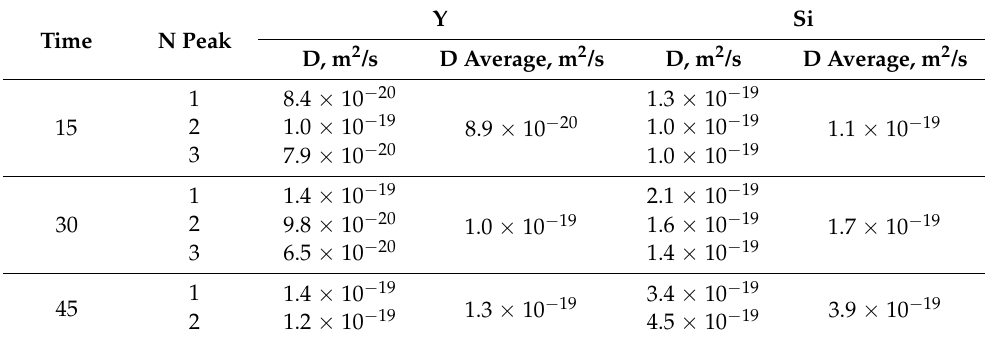
Table 2. The relationship between silicon and yttrium diffusion rates in the layers and its effect on annealing time at a temperature of 700 ◦ C in a multilayer [20]: coating. Time N